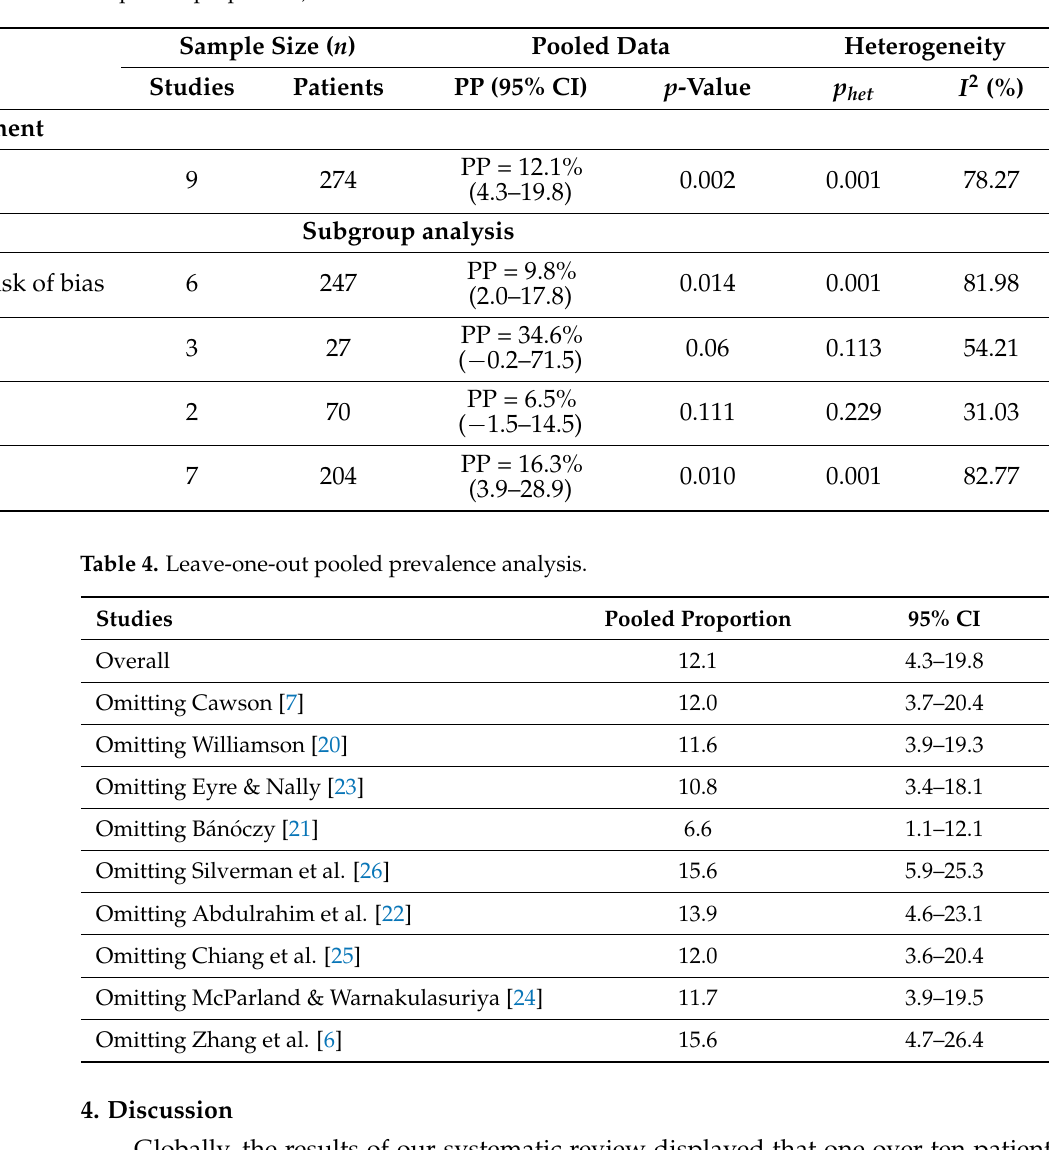
Table 3. Pooled prevalence, malignant transformation rate, and subgroup analysis of the initial histopathological diagnosis of CHC (CI: confidence intervals; CHC: chronic hyperplastic candidiasis; PP: pooled proportion).